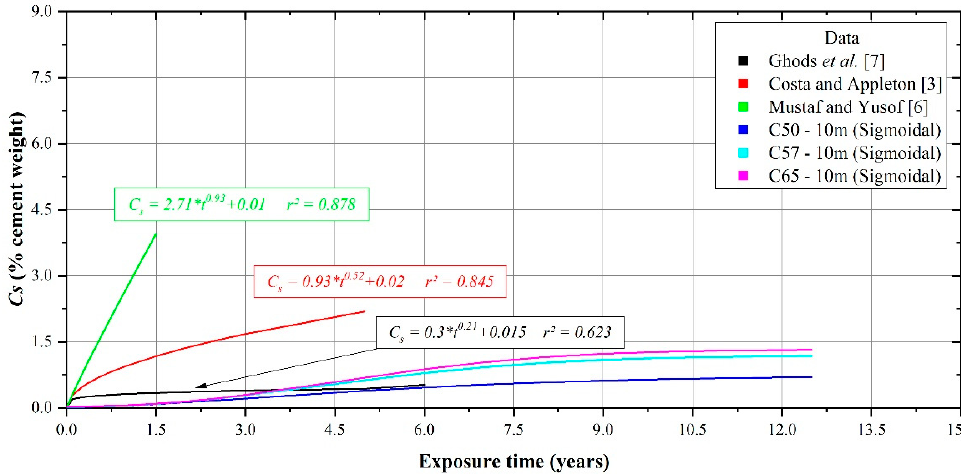
Figure 9. Fitting curves representing the literature data and the data from the present work [3,6,7].